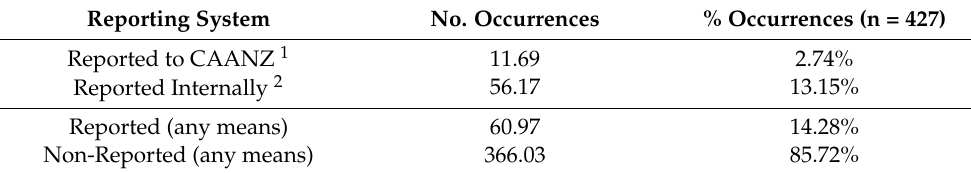
Table 4. Number and percentage of occurrences that were reported using different